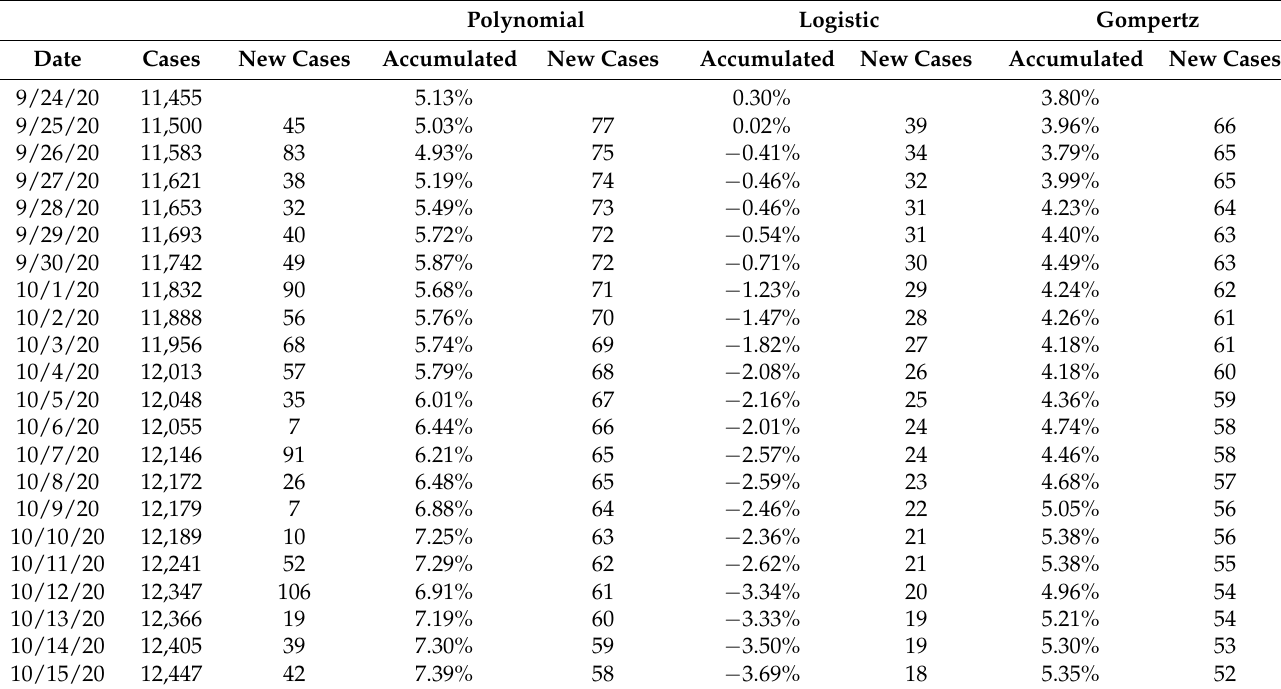
Table 7. Daily new COVID-19 cases predicted from total cumulative cases in the state of Quintana